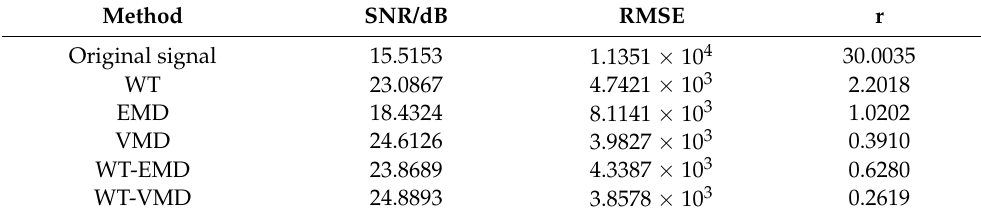
Table 5. Evaluation index of 100-pulse cumulative signal (with aerosol and clouds) after denoising.